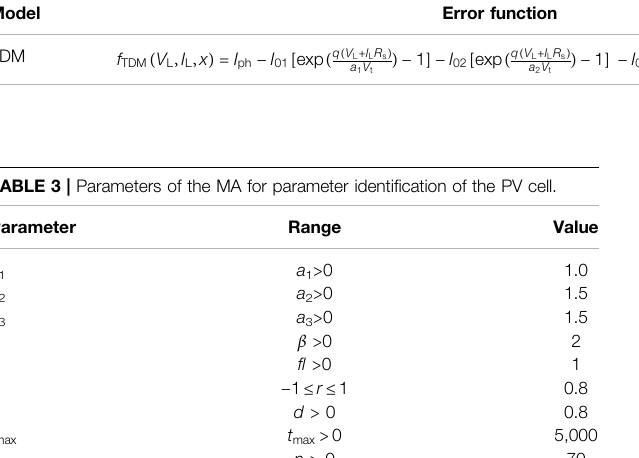
TABLE 2 | Error functions of the TDM.